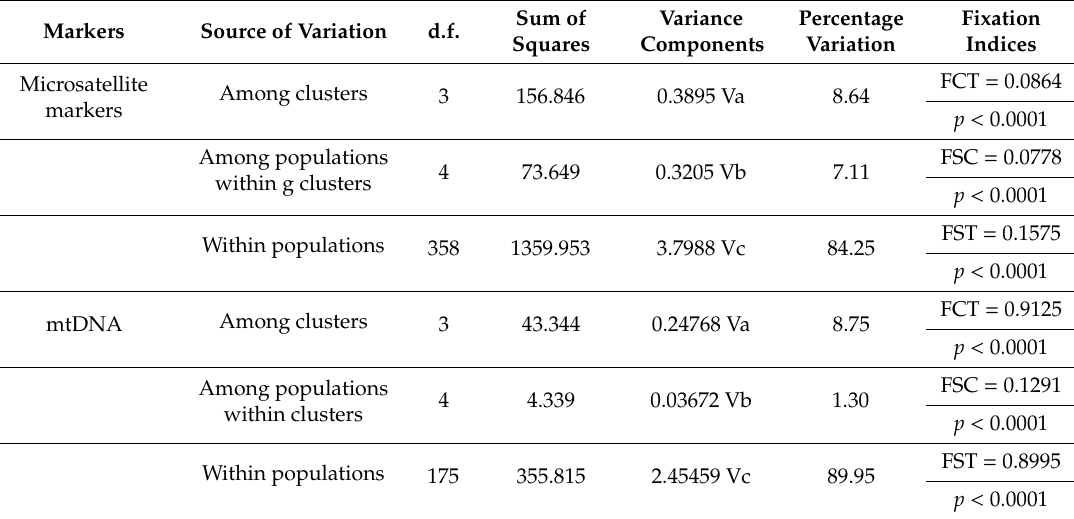
Table 4. AMOVA results of eight L. delicatula populations between four clusters inferred from STRUCTURE analysis based on microsatellite and mtDNA datasets.